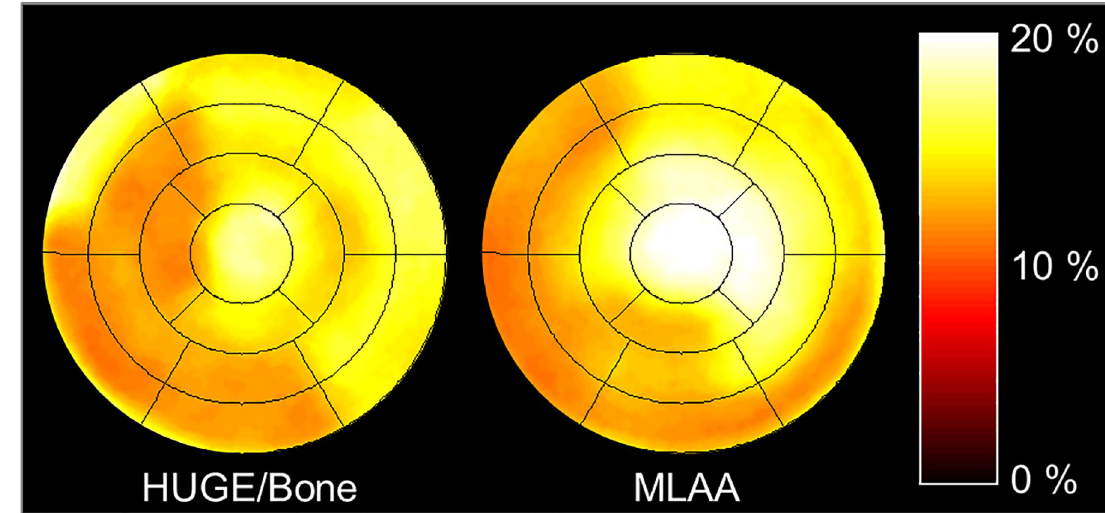
Fig 5. Patient example with maximal relative differences. The 17-segment polar plot of a single patient example shows the relative difference between improved attenuation correction (AC) maps using HUGE truncation correction and bone detection (a) or MLAA truncation correction (b) compared to Dixon-VIBE AC-map serving as reference. In this patient example maximal relative differences between improved AC and standard Dixon-VIBE AC were observable across the entire patient population. Note that especially in segment 17 (apex) maximal difference values with 18.8% for HUGE + bone and 19.8% for MLAA were